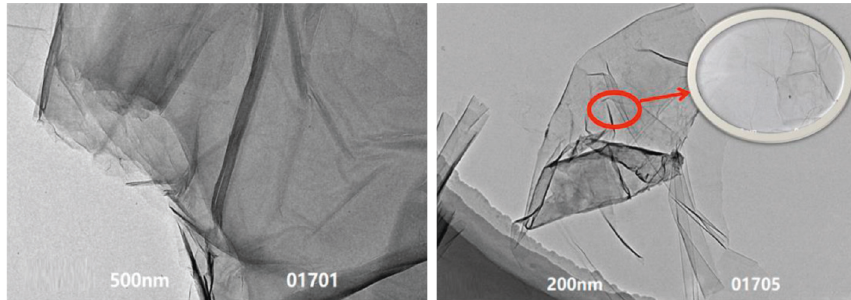
Figure 4: TEM images of modified GO.